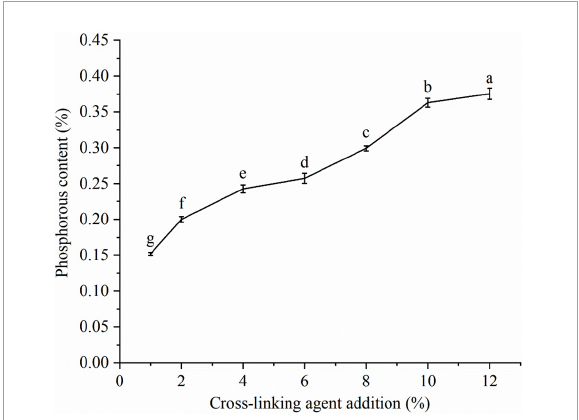
FIGURE2 Phosphorous content of lotus seed cross-linked resistant starch. Different lowercase letters represent significant differences ( p < 0.05).